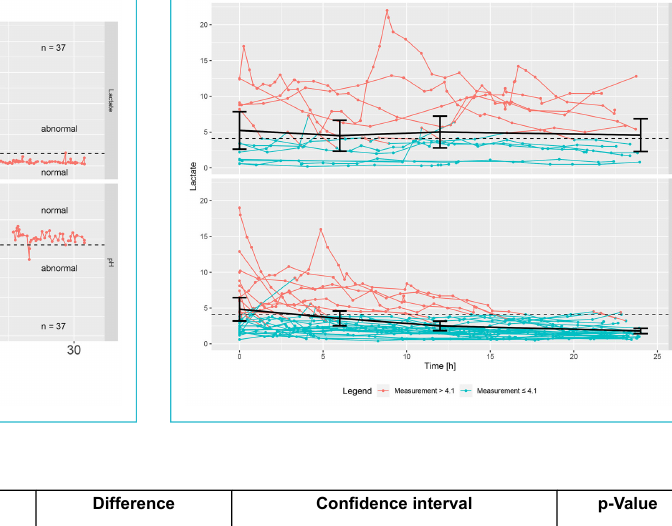
Figure 4: Serum lactate during the first 24 hours of intensive ther- apy in non-survivors (above) and survivors (below). The black dots and the line correspond to the means and 95% CIs of the first lac- tate values, at time 0, and to the latest lactate values before 6, 12 and 24 hours after the start of ECMO. Of note, if a line starts, for example, below 4.1 and goes over the threshold of 4.1, it is still displayed as blue, since the measurement was considered con- stant from this time point onwards until the next measurement.